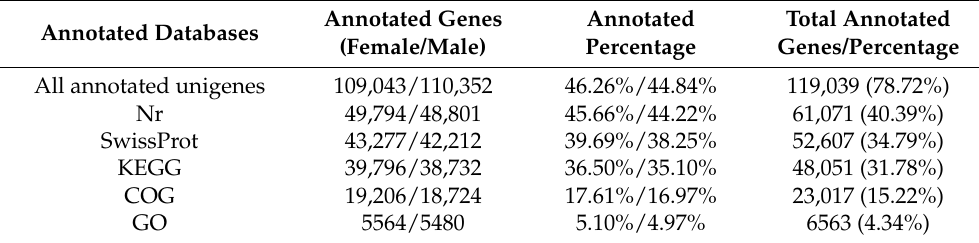
Table 4. Summary for annotated